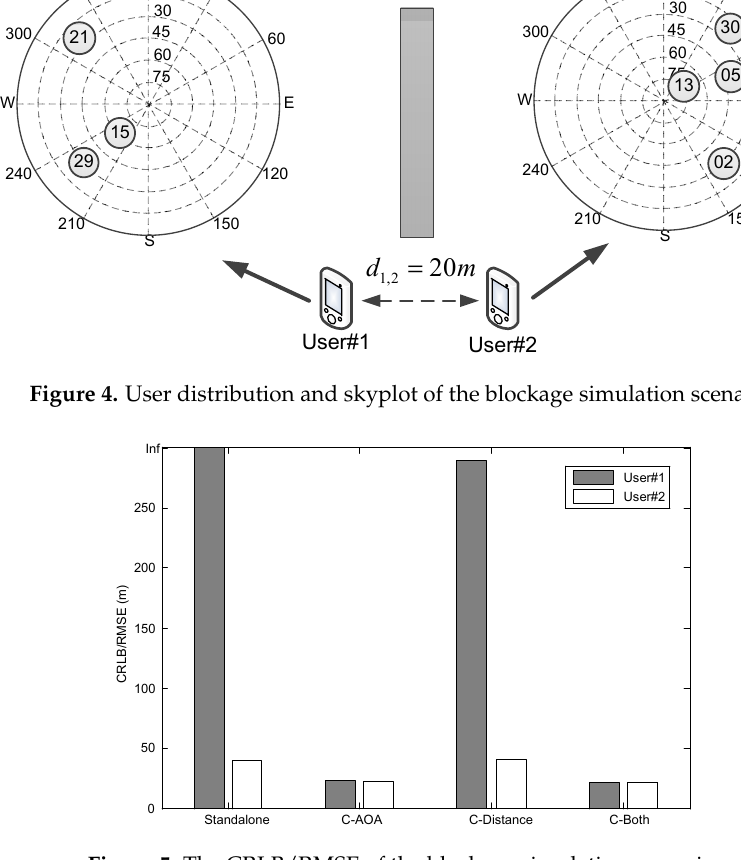
Figure 5. The CRLB/RMSE of the blockage simulation